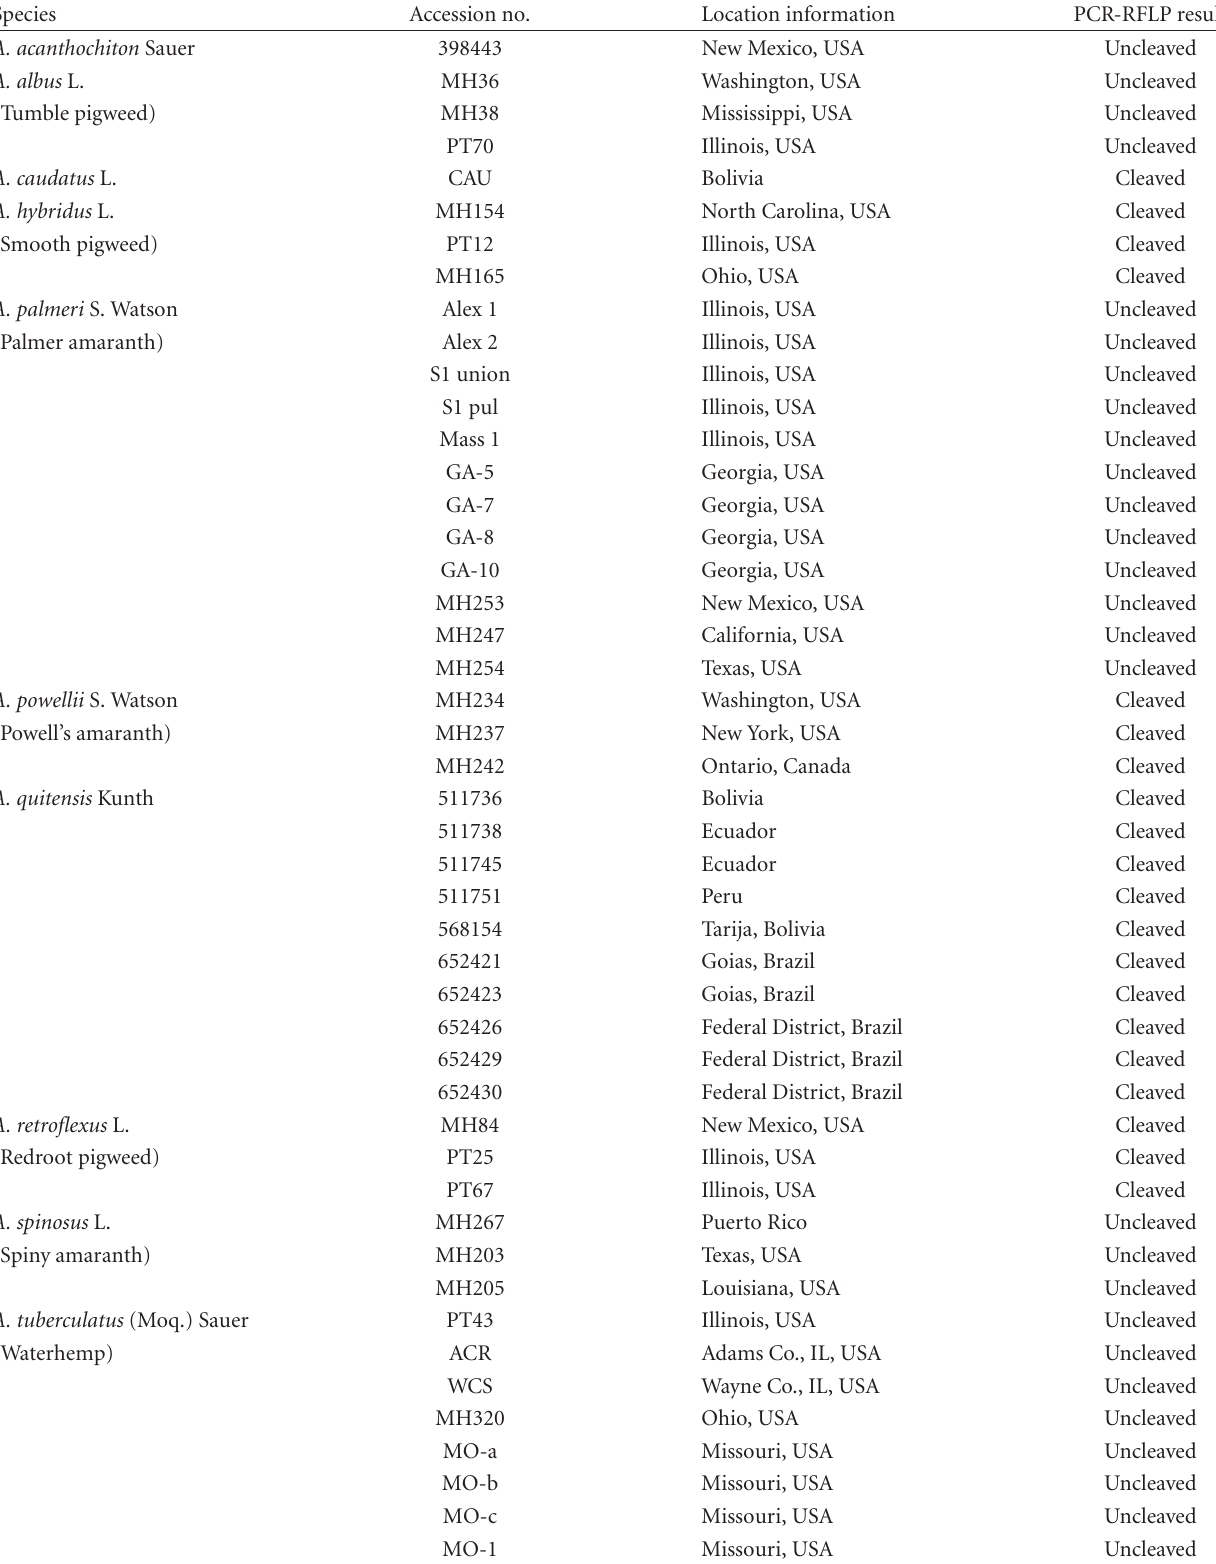
Table 1: Amaranthus accessions tested for PPX2 sequence